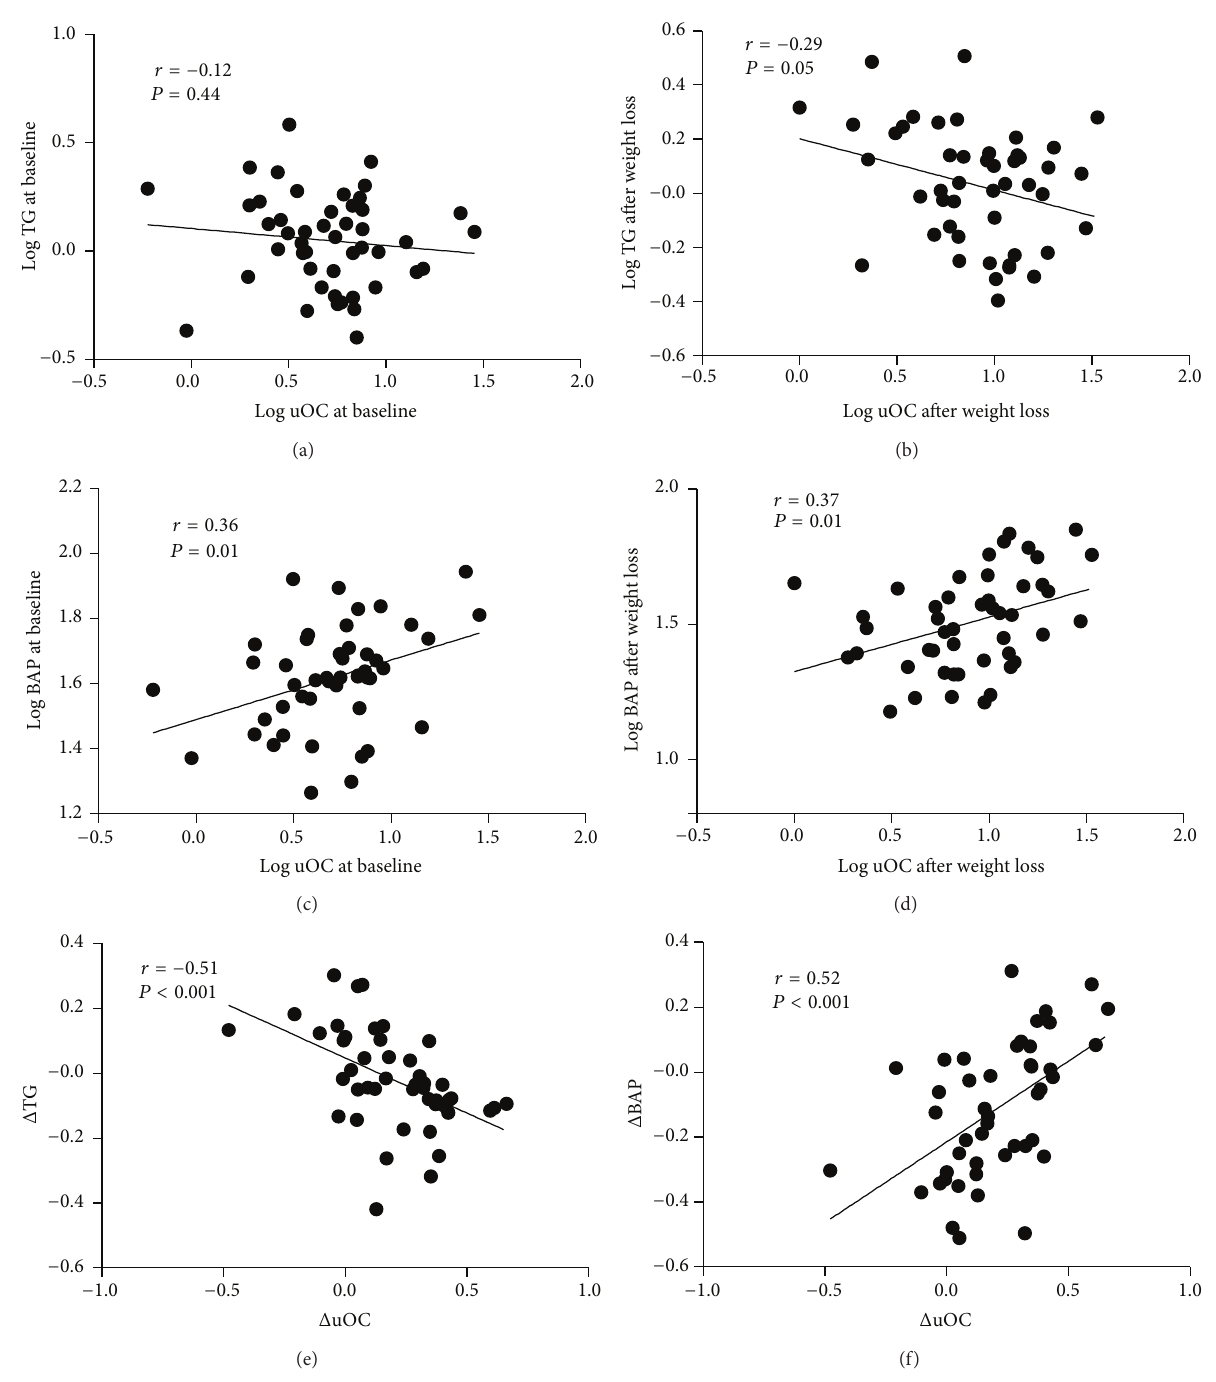
Figure 1: The correlation of serum undercarboxylated osteocalcin (uOC) with serum triglycerides (TG) and bone-specific alkaline phosphatase (BAP). Serum TG did not correlate with uOC at baseline ( 𝑟 = − 0.12, 𝑃 = 0.44 ) (a) but showed a negative correlation with uOC after weight loss ( 𝑟 = − 0.29, 𝑃 = 0.05 ) (b). BAP was positively correlated with uOC at baseline ( 𝑟 = 0.36 , 𝑃 = 0.01 ) (c) and after weight loss ( 𝑟 = 0.37 , 𝑃 = 0.01 ) (d). The changes in serum uOC levels were negatively correlated with changes in serum TG ( 𝑟 = − 0.51, 𝑃 < 0.001 ) (e) and positively correlated with changes in BAP ( 𝑟 = 0.52 , 𝑃 < 0.001 )